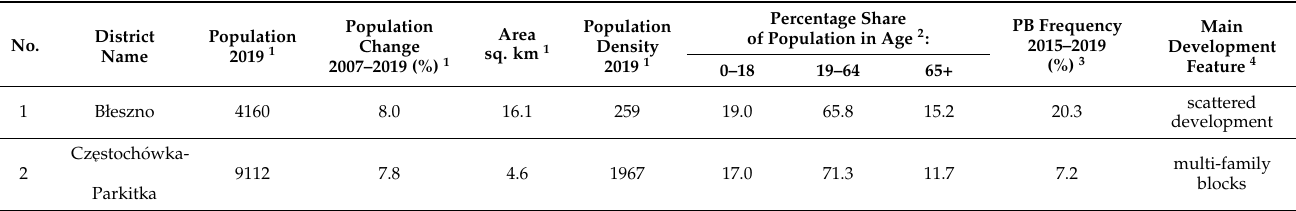
Table A1. Basic data on Cz˛estochowa urban districts used in